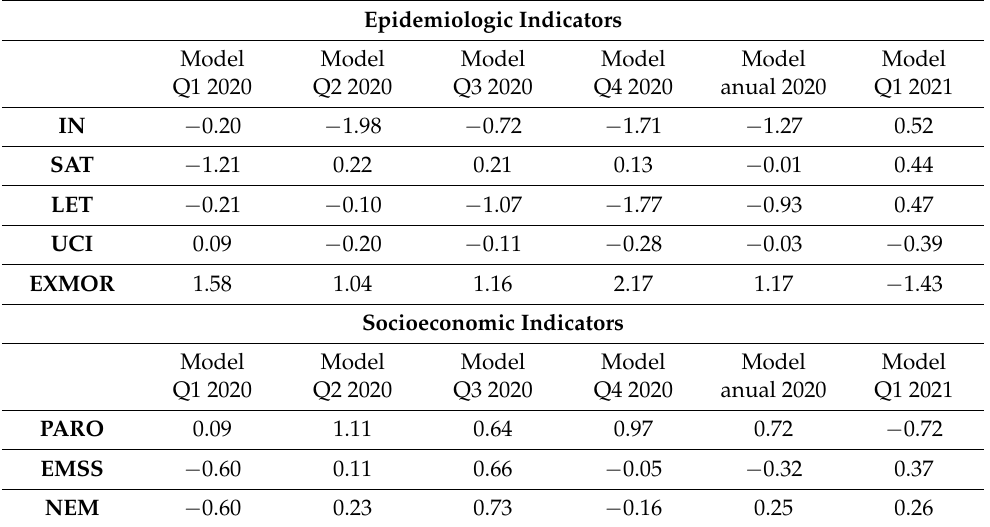
Table 3. Canonical loads for each of the models were